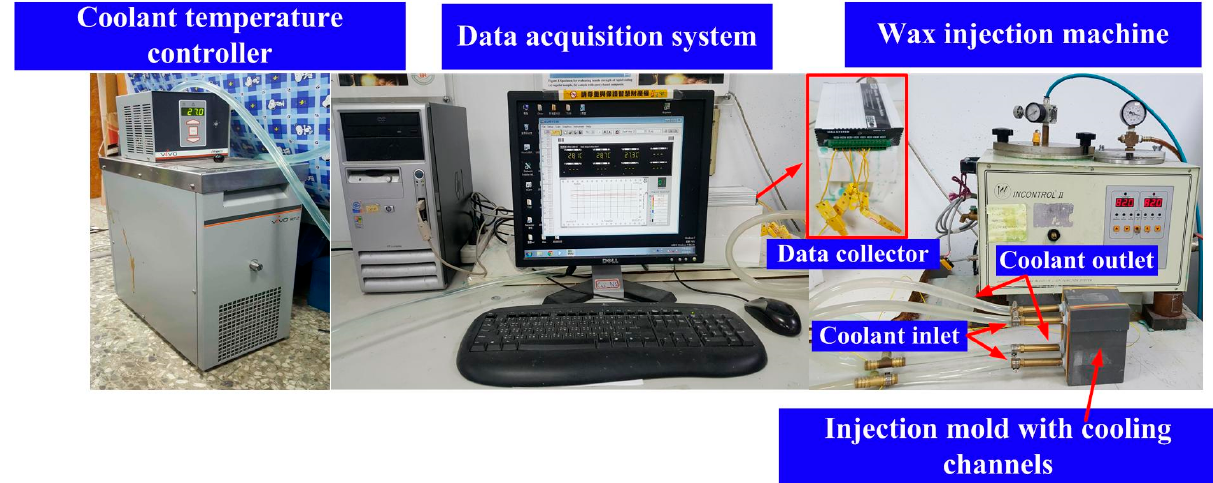
Figure 6. The layout of the experimental setup for investigating the cooling efficiency of the fabricated injection molds.